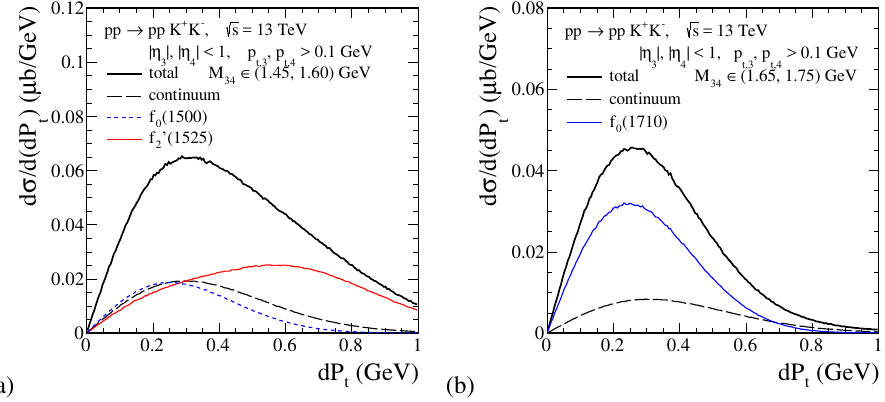
Figure 3. The di ff erential cross sections d σ/ d ( dP t ) as a function of the dP t “glueball filter” variable for the pp → ppK + K − reaction. Calculations were done for and in two dikaon invariant mass regions: (a) M 34 ∈ (1 . 45 , 1 . 60) GeV and (b) M 34 ∈ (1 . 65 , 1 . 75) GeV. No absorption e ff ects were taken into account